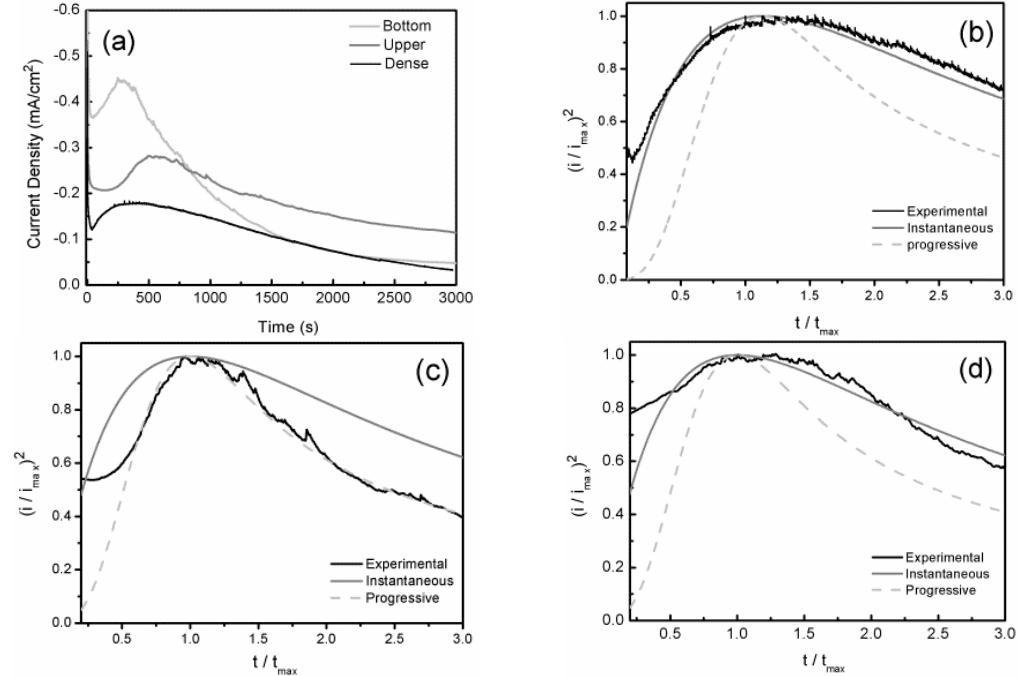
Figure 7. ( a ) Current against time transient plots recorded on dense and porous SLM-Ti samples and the experimental data measured on ( b ) dense SLM-Ti samples, ( c ) top surfaces, and ( d ) bottom surfaces, respectively, of porous SLM-Ti samples are compared to the simulated data for 3D nucleation models.